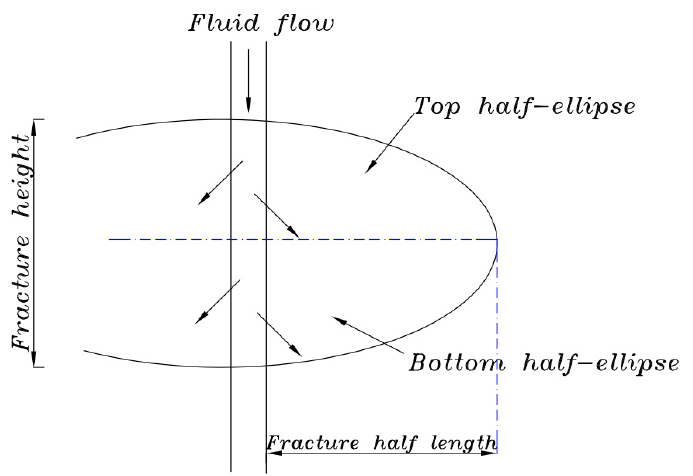
Figure 8. Schematic of fracture geometry on the basis of P3D model: the direction of fracture is perpendicular to the direction of fluid flow with an ellipse range.